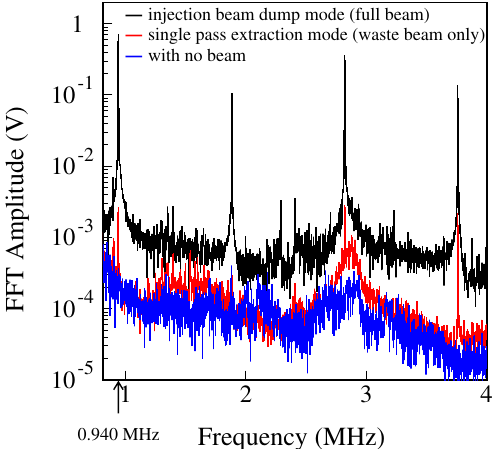
FIG. 6. Frequency spectra with an FFT analysis of the raw signal of H0CT. Data shown by the red color corresponds to the raw signal as shown in Fig. 5, whereas data shown by the black and blue colors correspond to the FFT spectrum with all of the injected beam transported to the H0 dump and no beam for noise level,